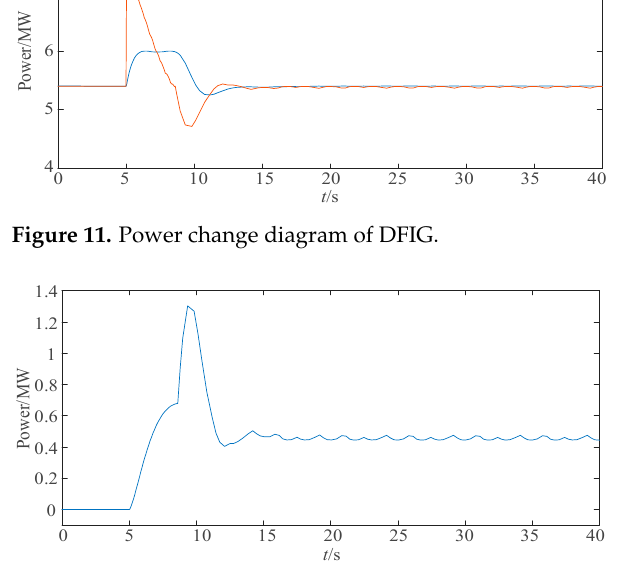
Figure 12. Power change diagram of energy storage.